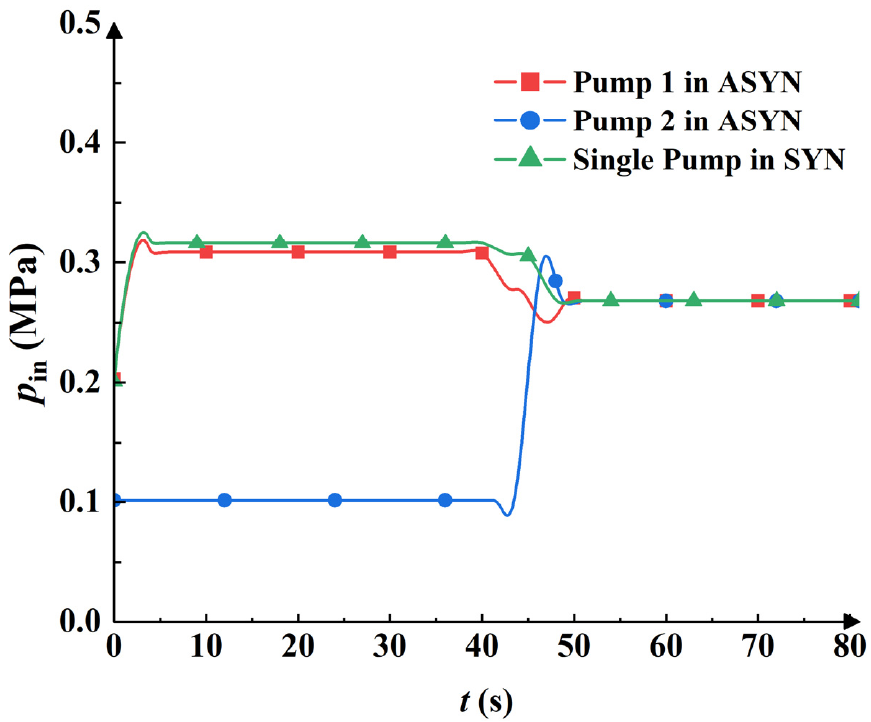
Figure 12. Comparison of pump inlet pressure in scheme ASYNC vs. scheme SYNC.